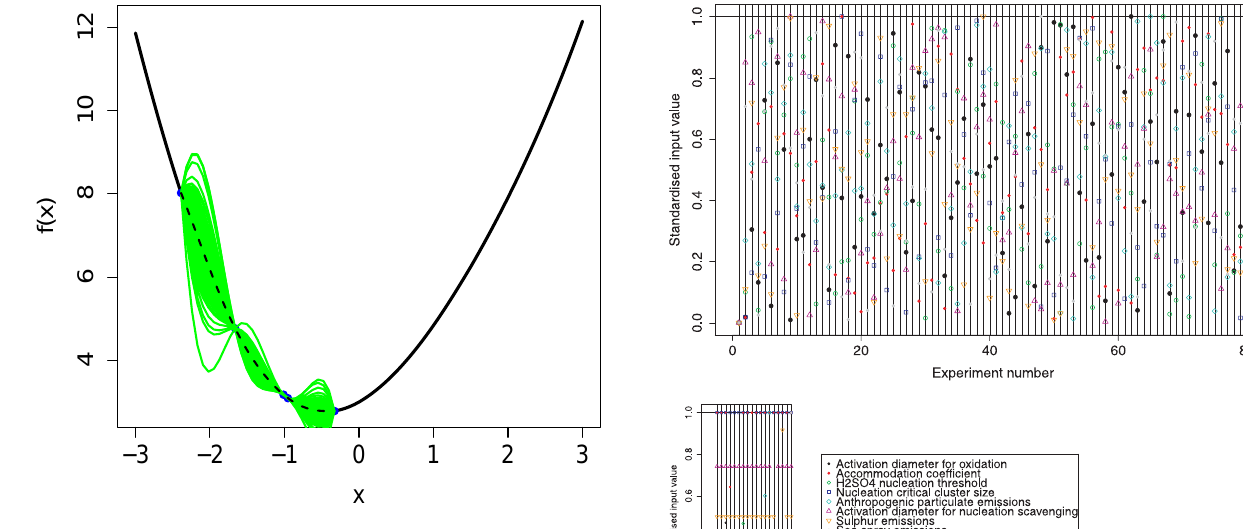
Fig. 3. 600 realisations from a one-dimensional emulator of the same curve in Fig. 2 but trained by five poorly spaced points. The uncertainty outside the training data is so great that the mean can not be considered representative of the true curve. Extrapolation should be avoided where possible.